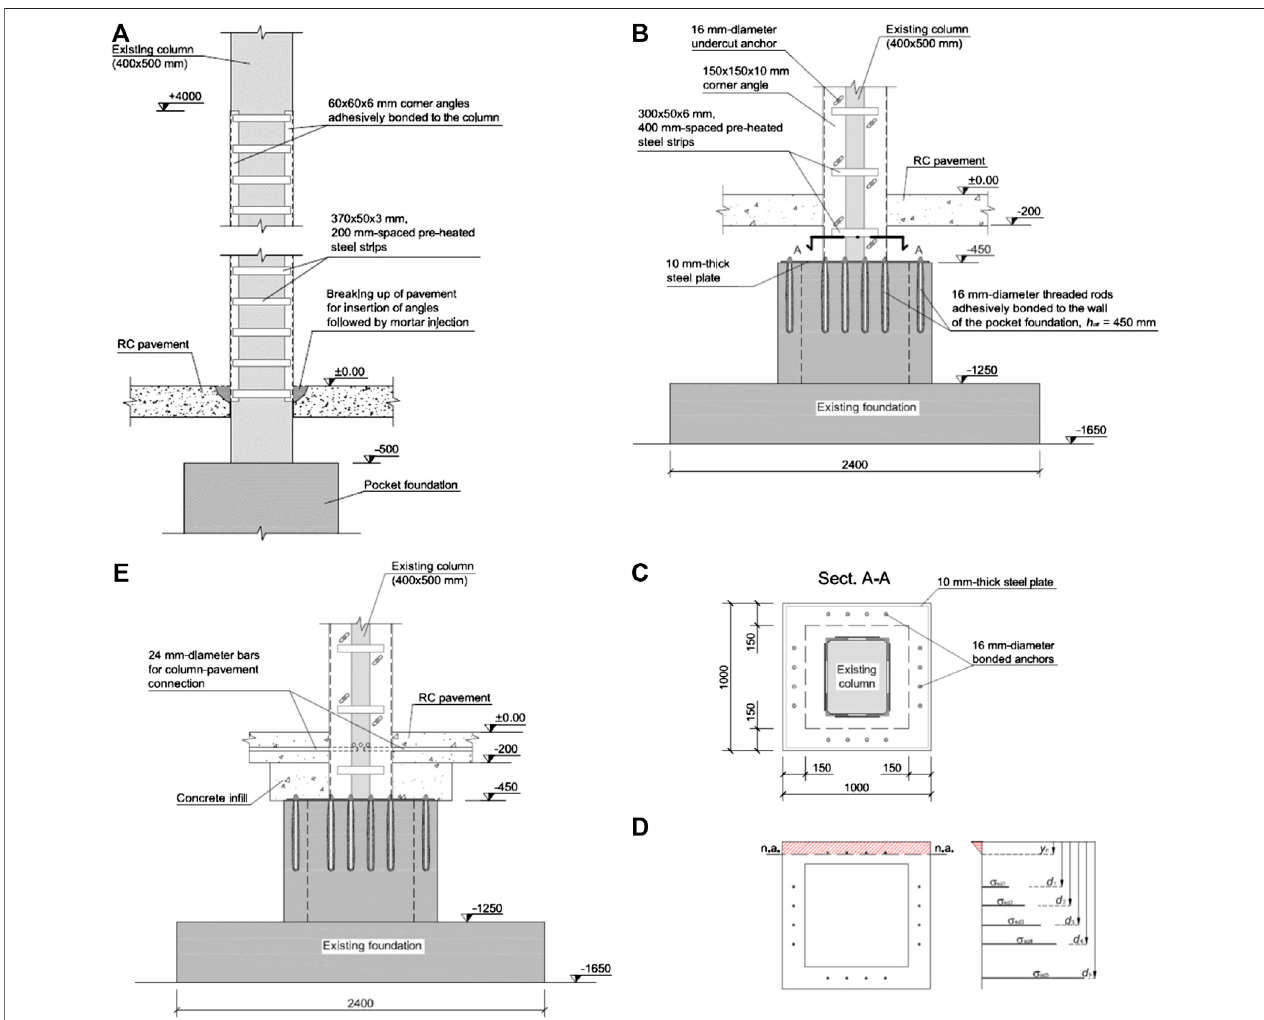
FIGURE2| SteeljacketsappliedtoprecastRCcolumns: (A) corneranglesinsertedintothepavementbutnotanchoredtothefoundation; (B) jacketconnectedto the pocket walls by means of bonded anchors, (C) corresponding in-plan anchors arrangement and (D) calculation model for bending resistance of the pocket; (E) the same as (B) plus column-to-pavement connection. Dimensions in